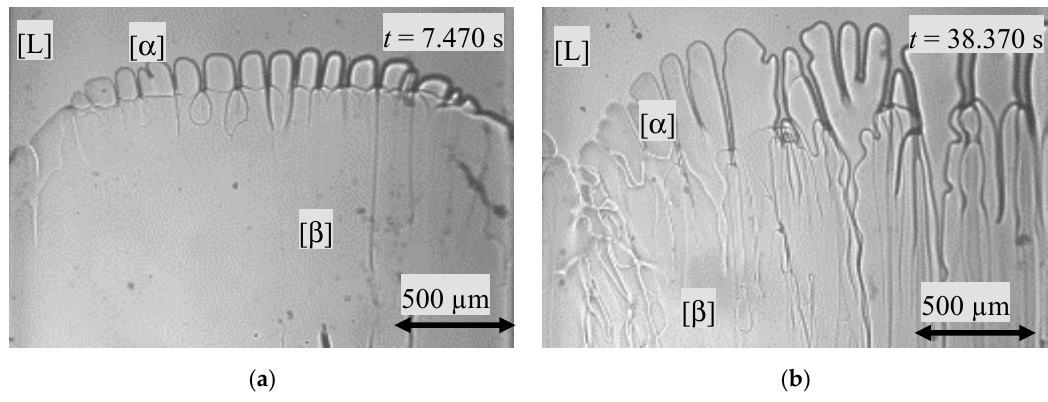
Figure 8. ( a ) The peritectic phase has enveloped the primary phase, but not entirely overgrown it. The solidification morphology of the primary phase shows deep cells from the peritectic phase flat cells. ( b ) The growth morphology has shifted from a cellular to a dendritic-like growth morphology.